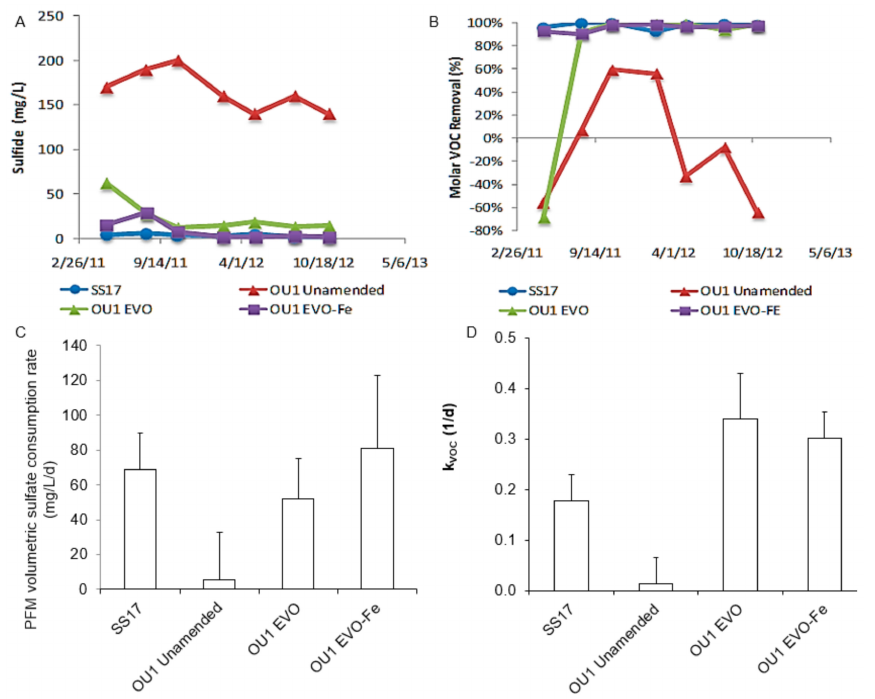
Figure 9. Comparison of VOC removal, sulfide production and SO 42 − consumption. ( A ) Biowall sulfide concentrations; ( B ) Percent VOC removal trends; ( C ) Average volumetric SO 42 − consumption rate for T2 through T7; and ( D ) Average percent VOC removal for T2 through T7. Positive error bars represent one standard